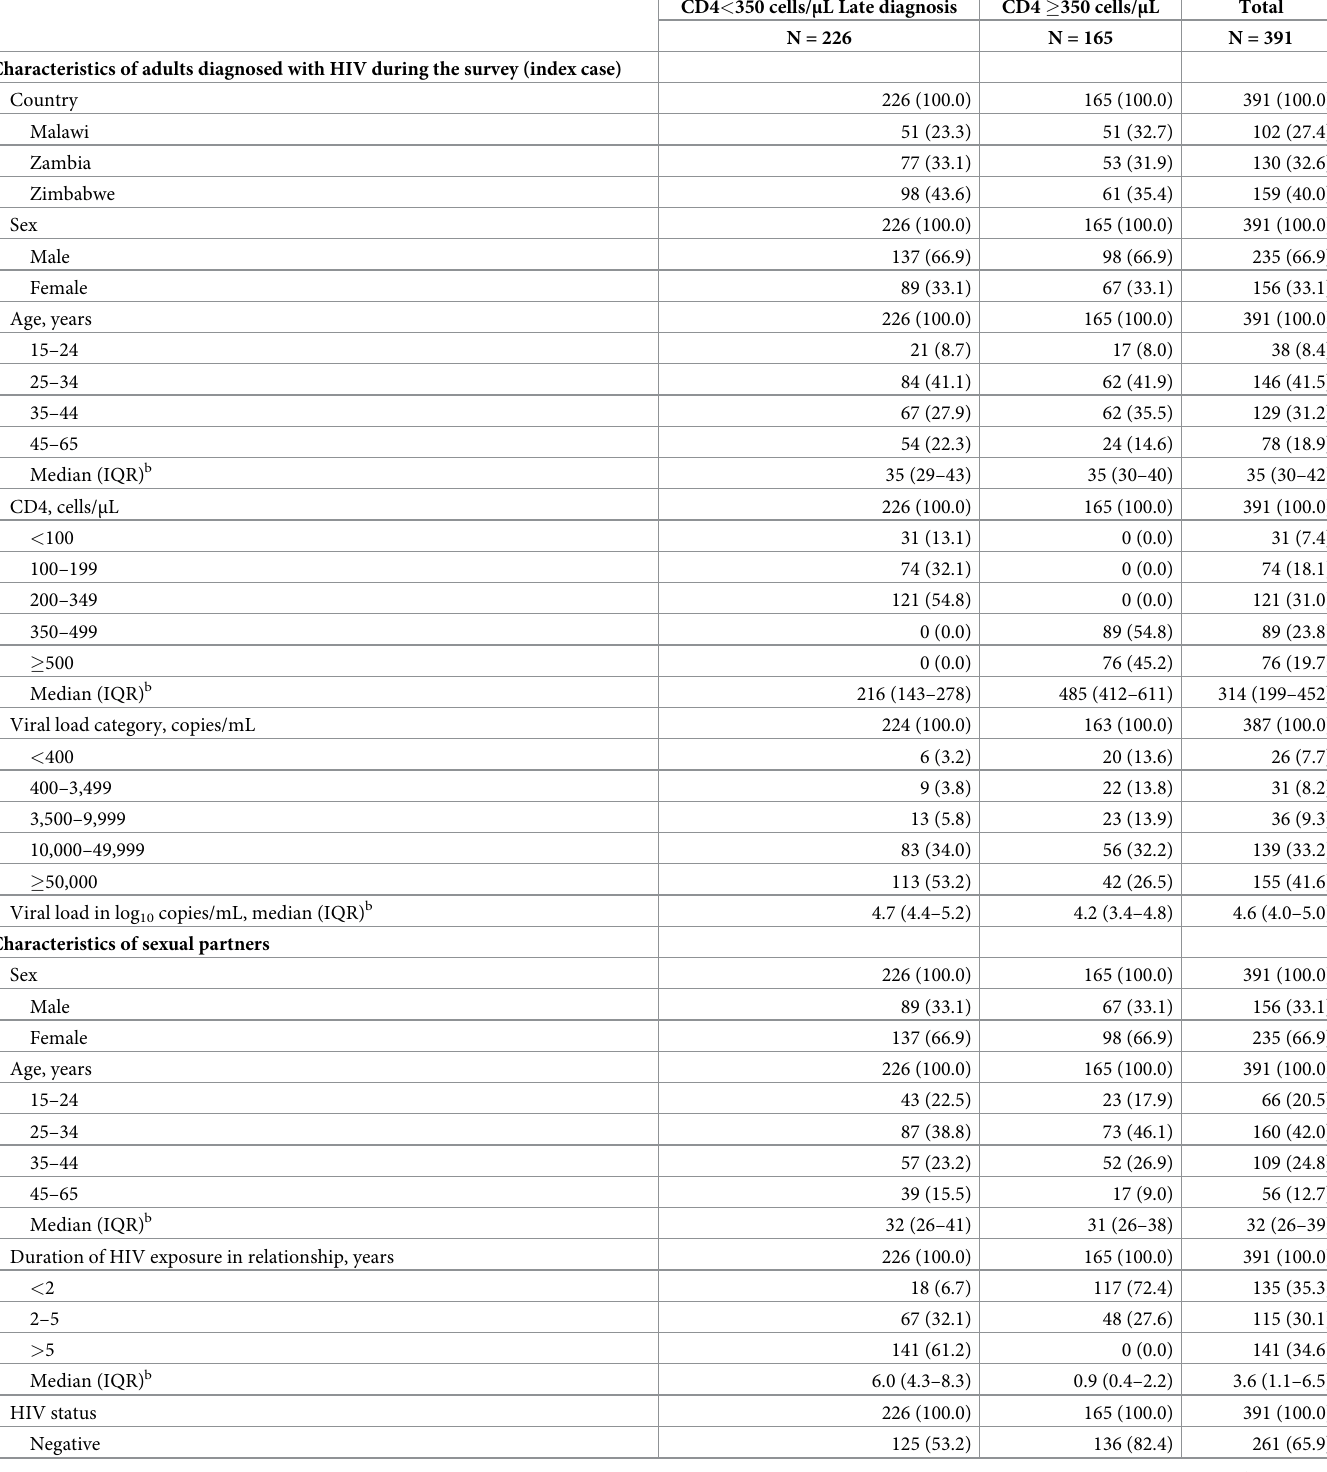
Table 4. Characteristics of partnered adults newly diagnosed with HIV during the PHIA surveys and who had a partner who agreed to HIV testing and was not on ART a